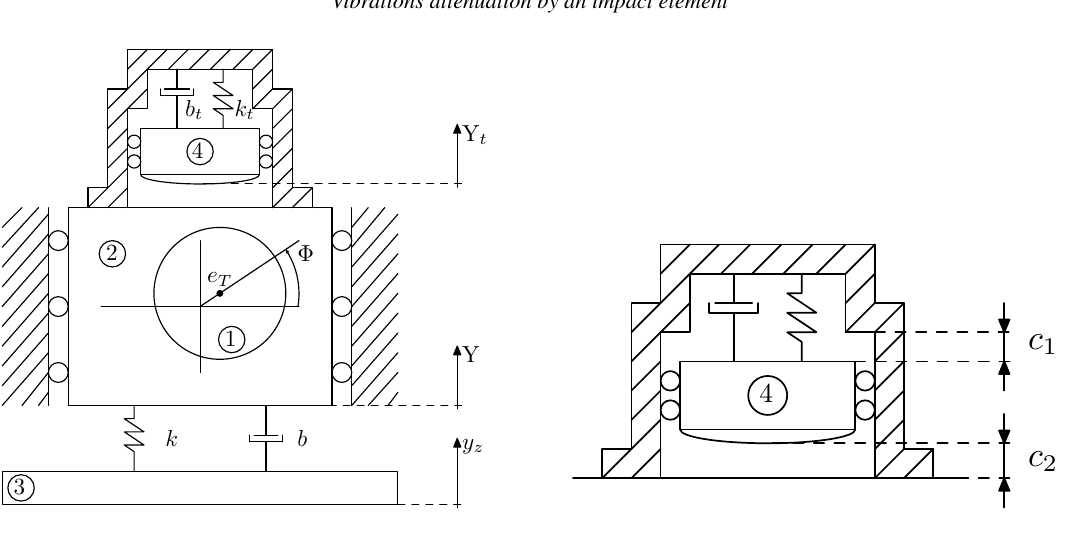
Fig. 1 Model of vibrating